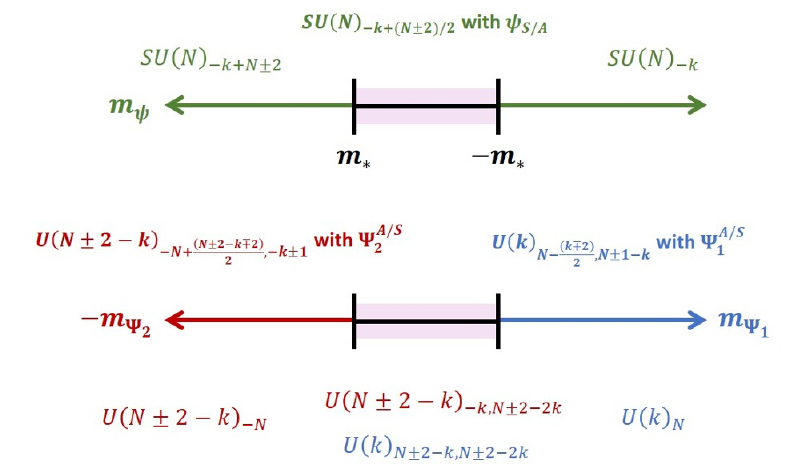
Figure 9 . Symmetric and antisymmetric representation phase